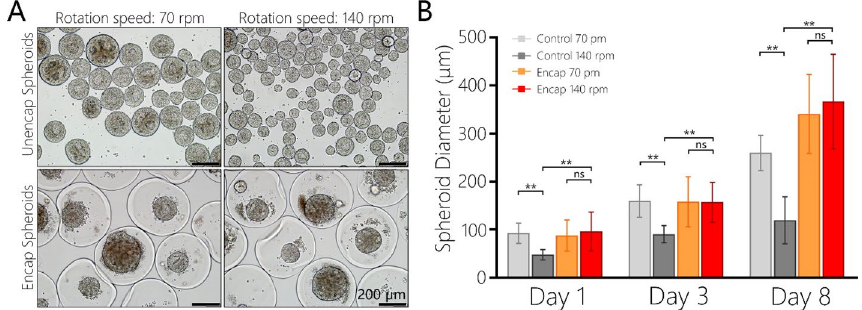
Figure 5. Assessing the effects of the speed of stirring on the size of spheroids. ( A ) Representative brightfield images of stem cell spheroids after 3 days of suspension cultures at 70 rpm and 140 rpm. ( B ) Analysis of spheroid diameter for encapsulated and control spheroids at 70 rpm and 140 rpm (n = 20, ** p <